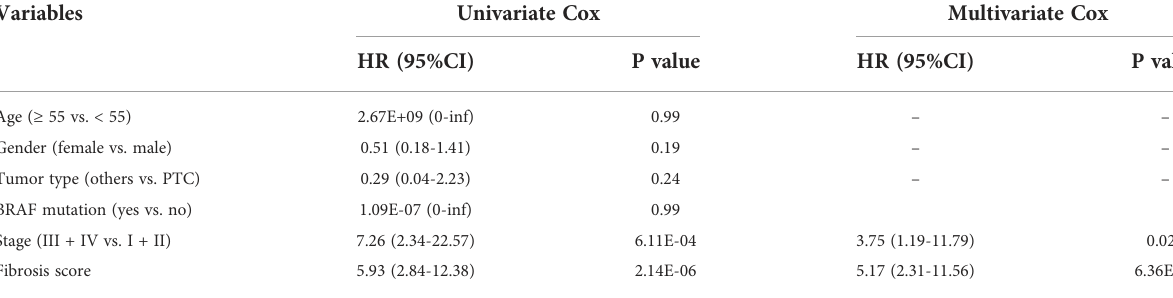
TABLE 1 Univariate and multivariate Cox regression analyses of fi brosis score in TCGA-THCA